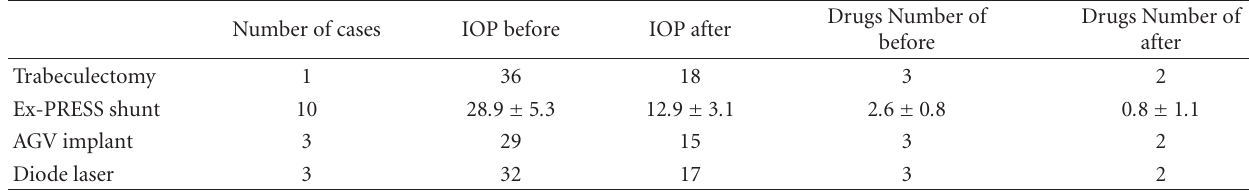
Table 6: The management of refractory post-keratoplasty glaucoma cases. The mean intraocular pressures (IOPs) in mmHg, the mean number of antiglaucomatous drugs before and after treatment.